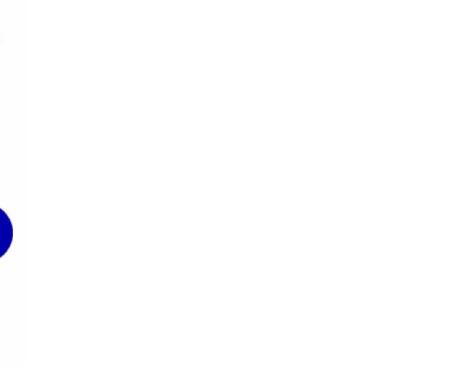
Figure 1. Schematic diagram of lattice distortion of five-component high-entropy alloy [21].